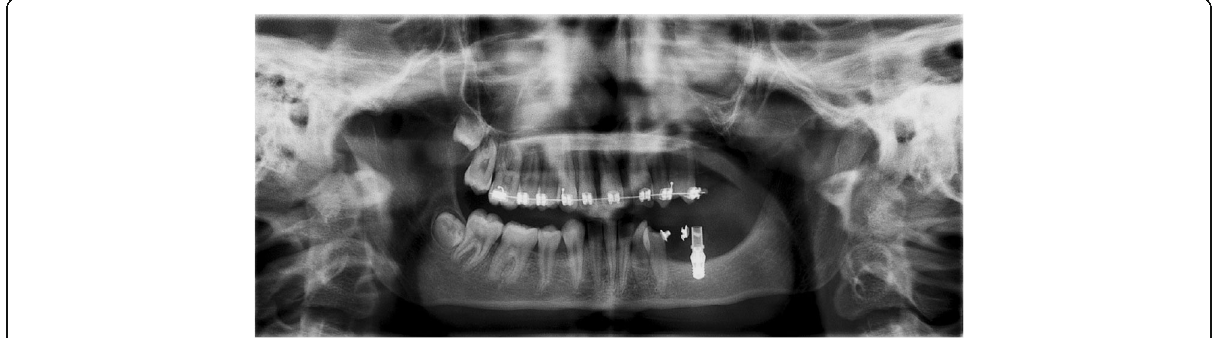
Fig. 7 Patient 2 — post-operative orthopantomogram (OPT) at age of 13. Situation 10 months after implant placement. Three months